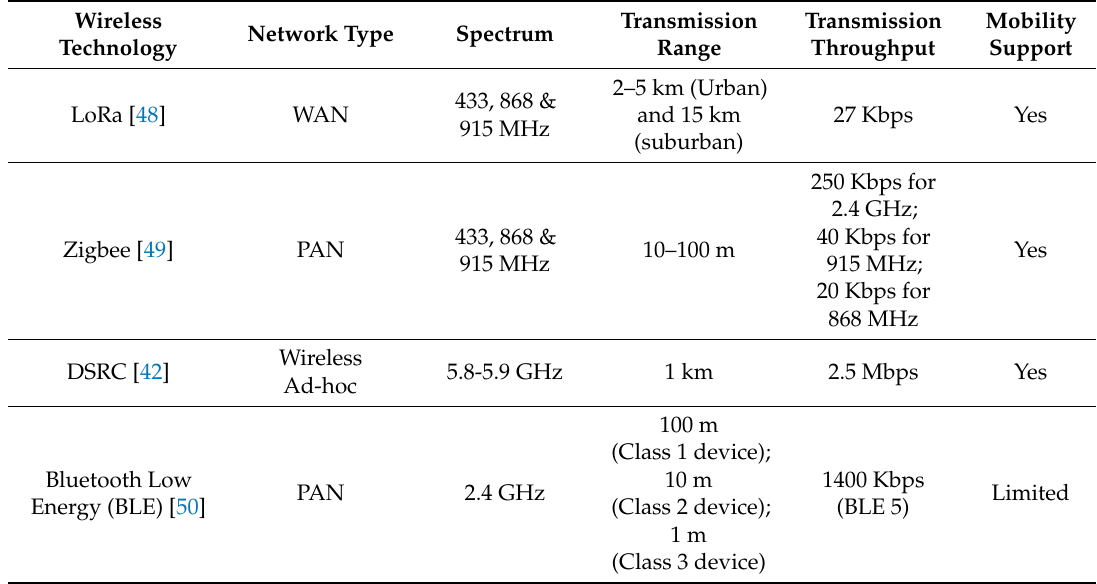
Table 1. Comparison of di ff erent wireless technologies used in